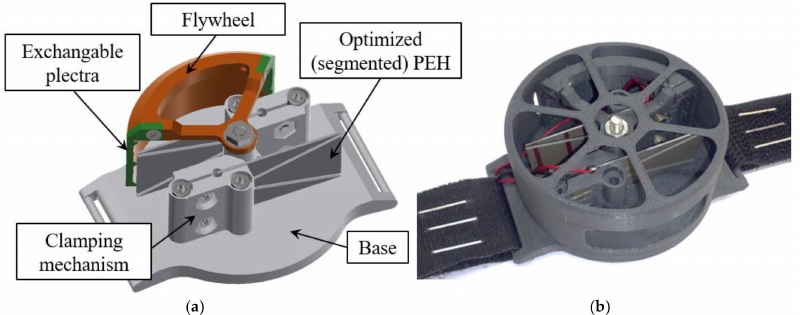
Figure 5. Schema of the devised watch-like wearable PEH device with two optimized segmented bimorph cantilevers ( a ) and the first prototype of the device ( b